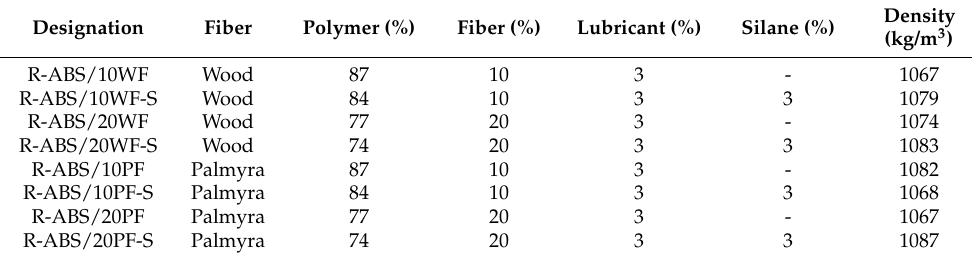
Table 3. Composition of recycled polymer